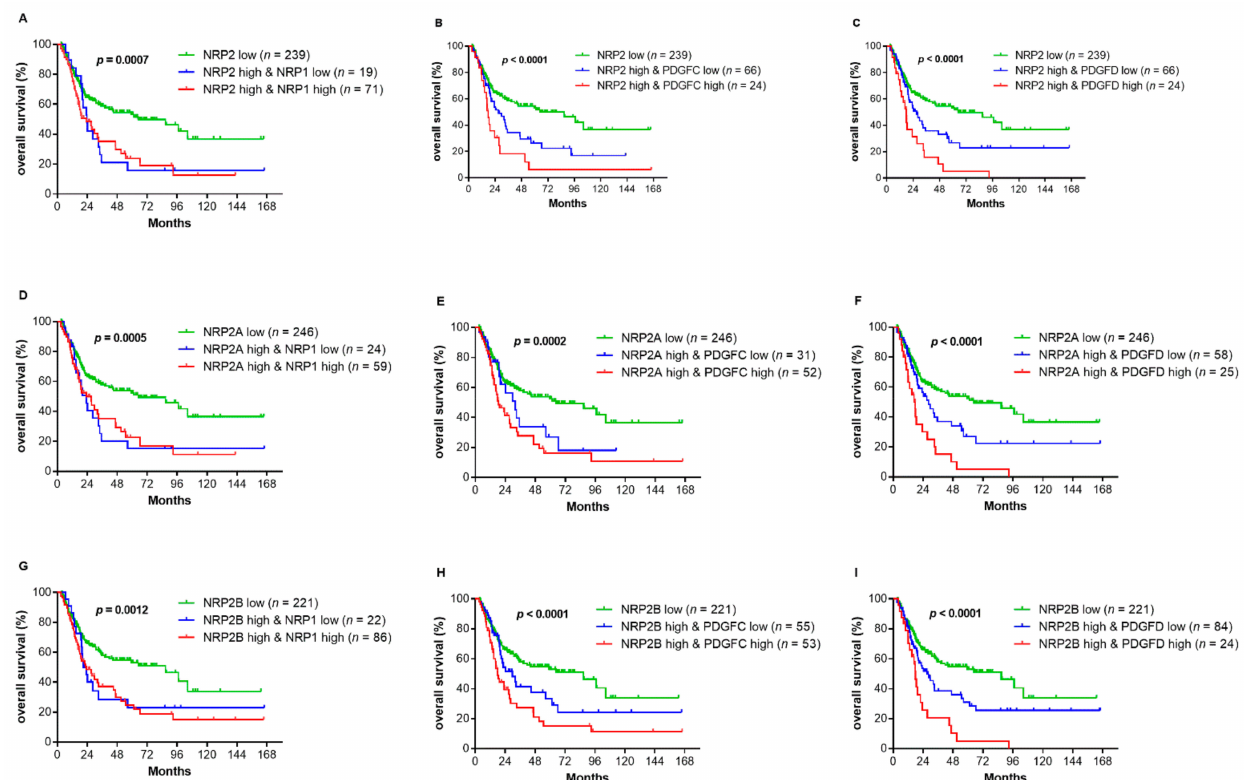
Figure 5. Kaplan–Meier curves of overall survival (OS) of marker combinations. A–C: NRP2 and NRP1 ( A ), PDGFC ( B ) or PDGFD ( C ). D–F: NRP2A and NRP1 ( D ), PDGFC ( E ) or PDGFD ( F ). G–I: NRP2B and NRP1 ( G ), PDGFC ( H ) or PDGFD ( I ). The cut-off values for high and low gene expressions were determined by a partition test with each group representing at least 20% of the total cohort. For the subsequent division of the high expression subgroup, the sample size was adjusted and a partition test with a 20% minimal group size was repeated. Significant p values are printed in